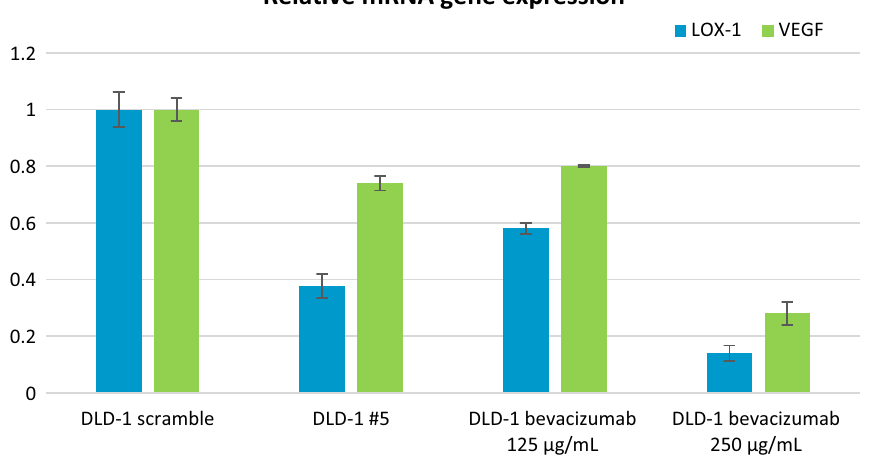
Figure 4. Relative gene expression of LOX-1 and VEGF-A for the four investigated classes: Control Colorectal cancer cells class (DLD-1 scramble), DLD-1 with stably down modulated LOX-1 (DLD-1#5), DLD-1 treated with Bevacizumab at 125 and 250